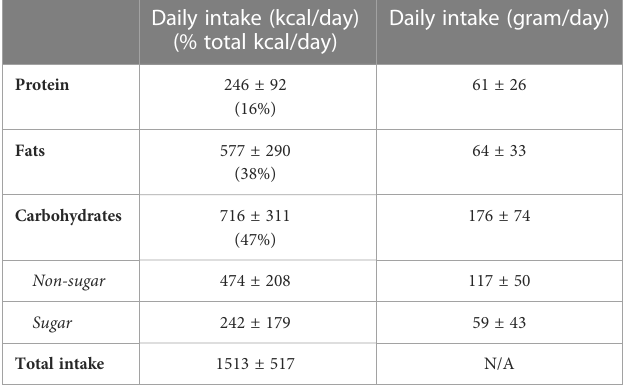
Datareportedasmeanintake±standarddeviation(SD)perdayofeachnutrientandtotalenergy intake. Mean proportion of nutrients of total caloric intake reported in